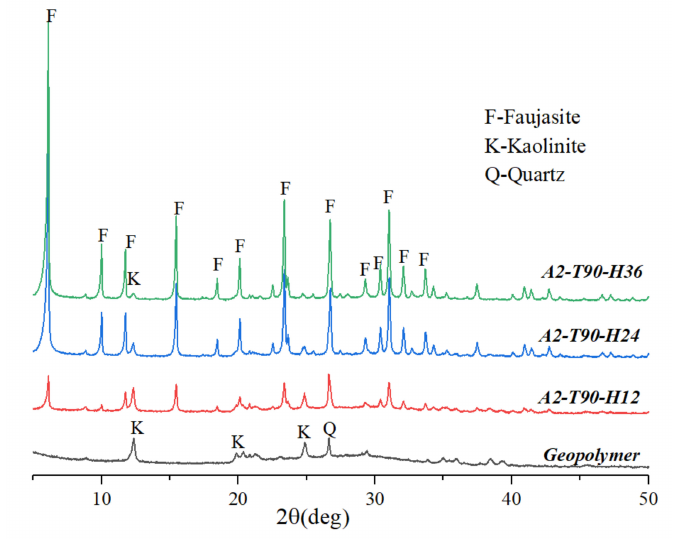
Figure 5. XRD patterns of samples synthesized at di ff erent hydrothermal time.